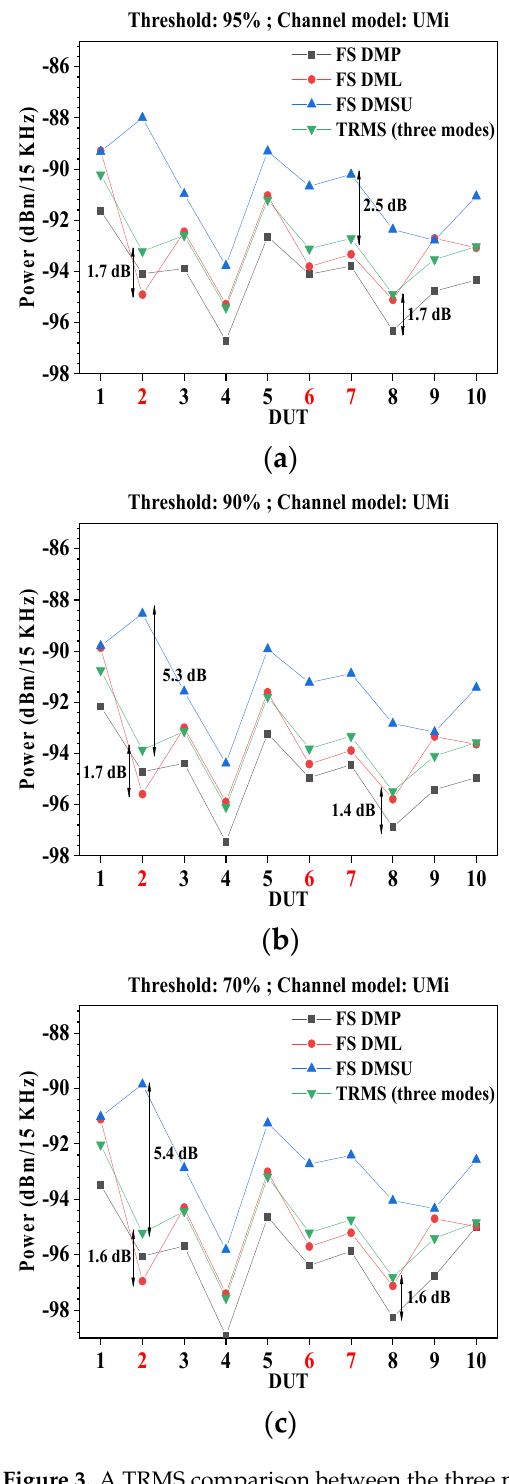
Figure 3. A TRMS comparison between the three modes and the averaged TRMS at all thresholds under the UMi channel model; ( a ) threshold = 95%, ( b ) threshold = 90%, ( c ) threshold = 70%. It can be observed that for both channel models, the averaged TRMS is almost the same as TRMS in FS DML for all DUTs at three thresholds, with a maximum deviation of around 1.6 dB. We can conclude that TRMS performance is mainly determined by FS DML mode under UE noise-limited environmental condition, which can be seen as the